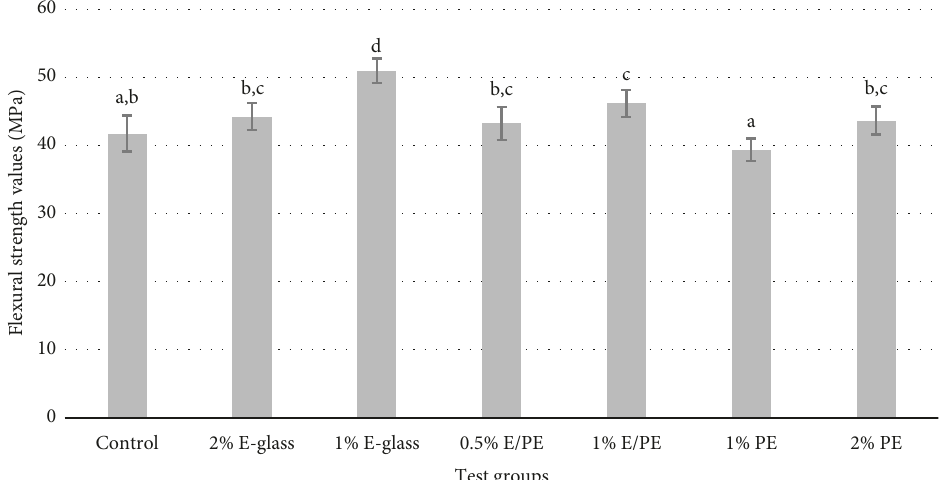
Figure 1: Bar chart representing the means and standard deviations of flexural strength test (MPa) of each tested group. Groups with the same lowercase superscripted letter indicated no significant differences between groups at p value < 0.05.